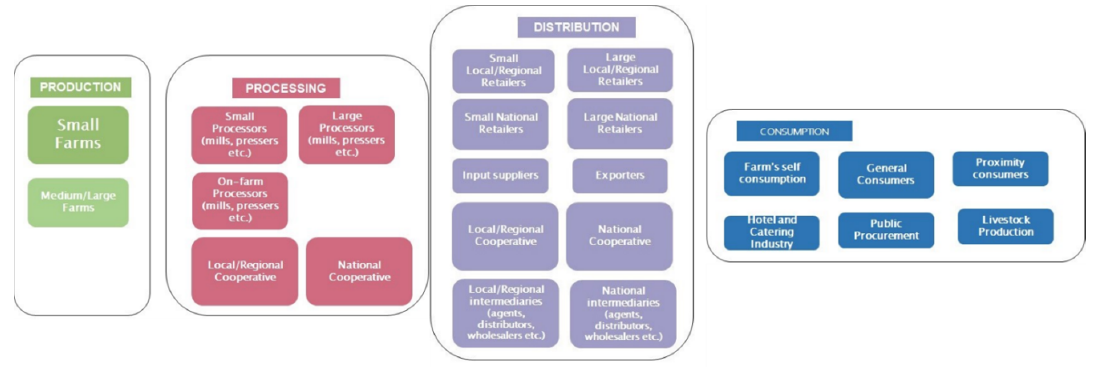
Figure A1. Example of a food system and its subsystem nodes.